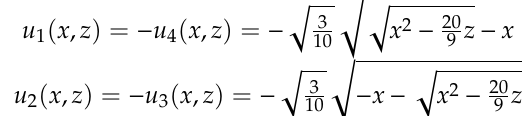
Figure 4. Function ( , ) P x y ( a ), function ( , ) (cid:12) (cid:12) ∆ P = (cid:12) P A ( x , y ) − P ( x , y ) difference